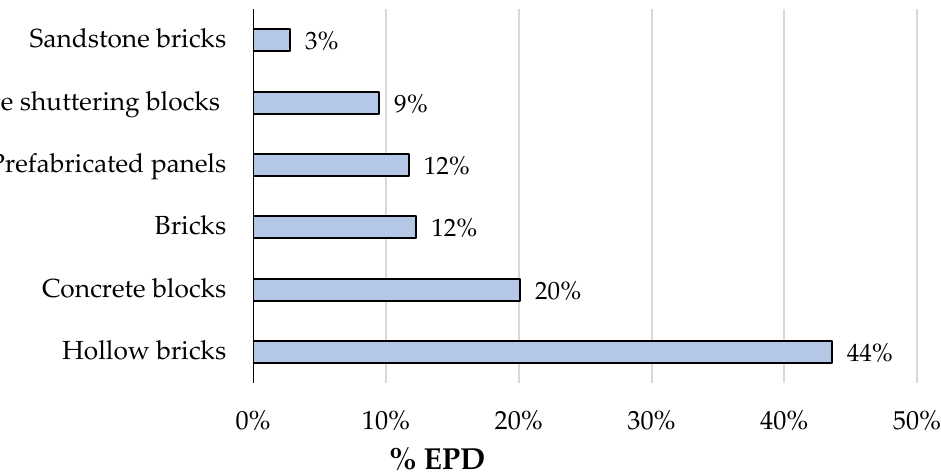
Figure 3. Percentage distribution of the various products of the sample.